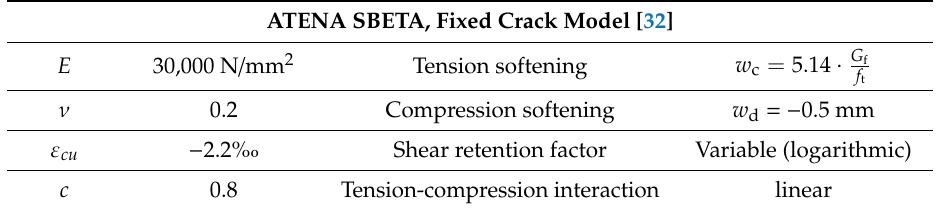
Table 3. Parameters for the numerical simulations with ATENA